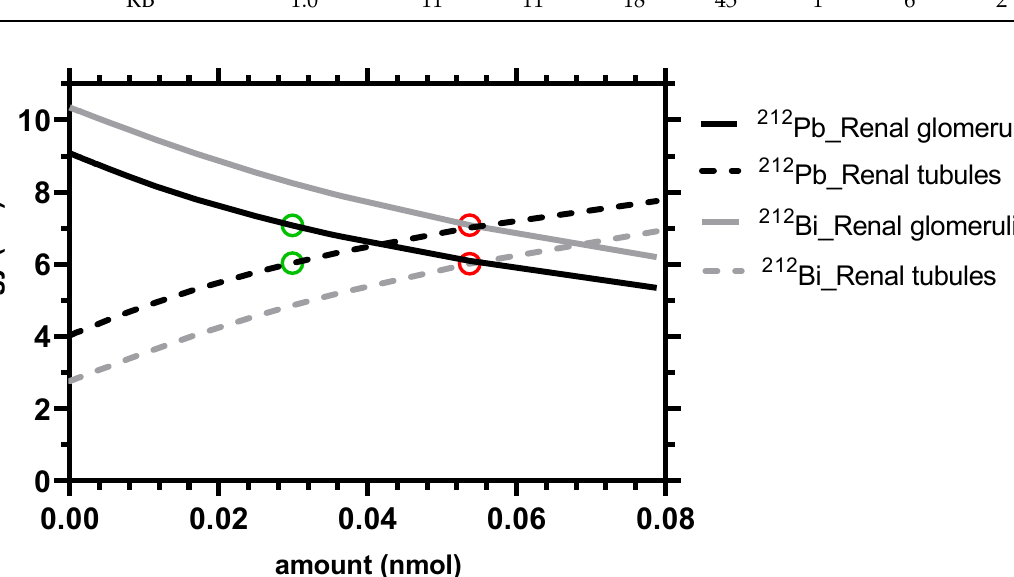
Figure 5. Therapeutic potencies of the in vivo alpha generator [ 212 Pb]Pb-SSTA (upper panel) and [ 212 Bi]Bi-SSTA (lower panel). The absorbed doses in different mouse tissues were calculated for dif- ferent injected amounts, with activity chosen such that kidneys always received a dose of 23 Gy. The absorbed doses in the other tissues of the model are presented in Supplementary Material Fig- ure S1.